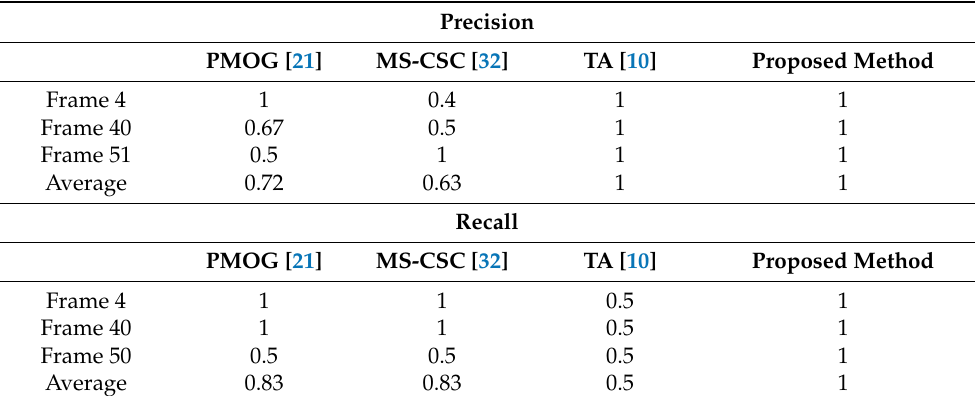
Table 1. Precision and recall table of object detection algorithm on rain-free video from different